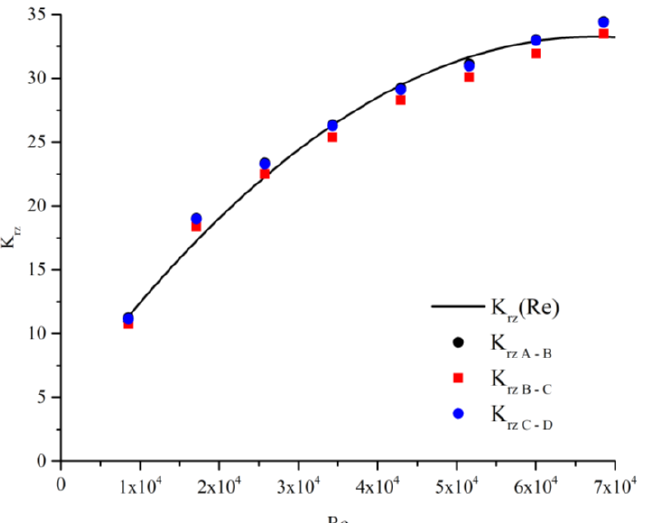
Figure 3. Friction anisotropy coefficient versus Re